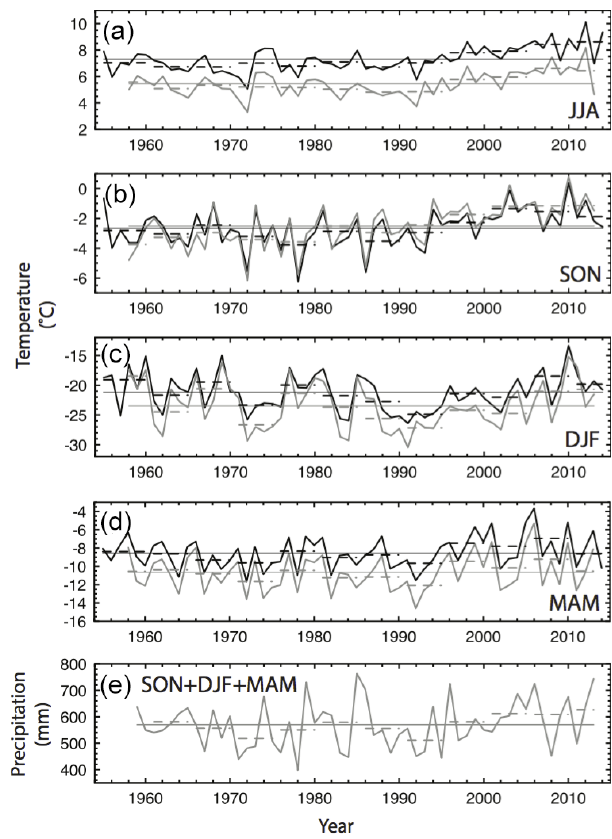
Figure 6. Time series of seasonal 2m air temperatures (a–d) , and preceding accumulation season (September–May) precipitation to- tals (e) , averaged across the region 58–60 ◦ N, 295–297 ◦ E, from Berkeley Earth (black lines) and JRA-55 reanalysis datasets (grey lines). Continuous solid lines are time-series averages, and dashed line segments are pentadal